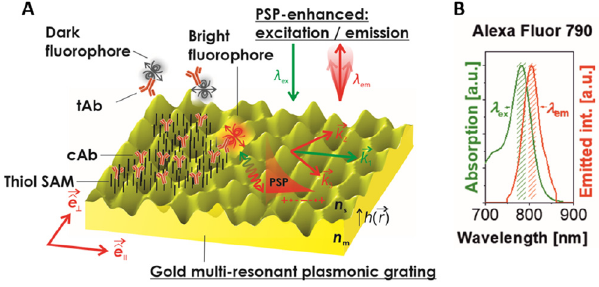
Figure 1: Concept of the MPG-based sensor